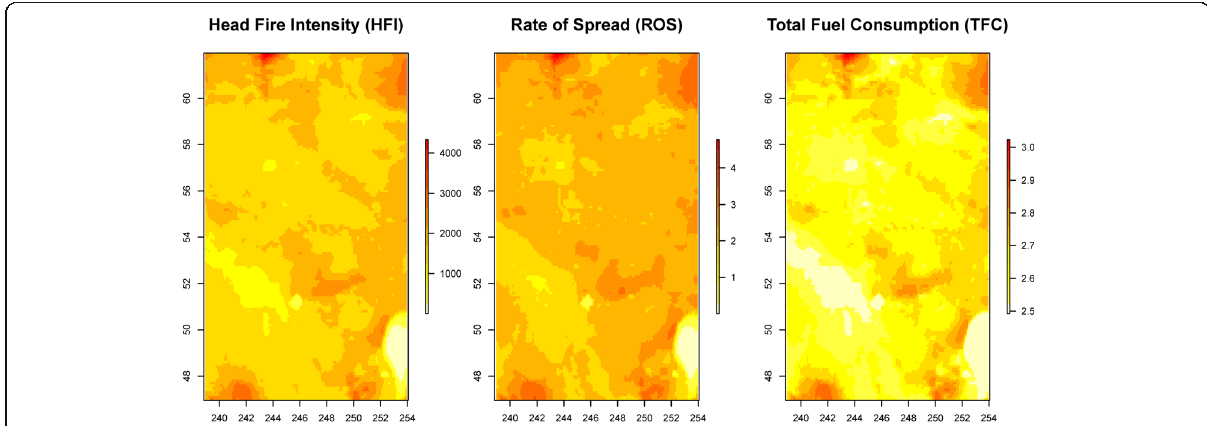
Fig. 6 Three major fire behavior prediction outputs based on hourly FFMC output from example (2), including head fire intensity (HFI, kW/m), head fire rate of spread (ROS, m/min), and total fuel consumption (TFC,